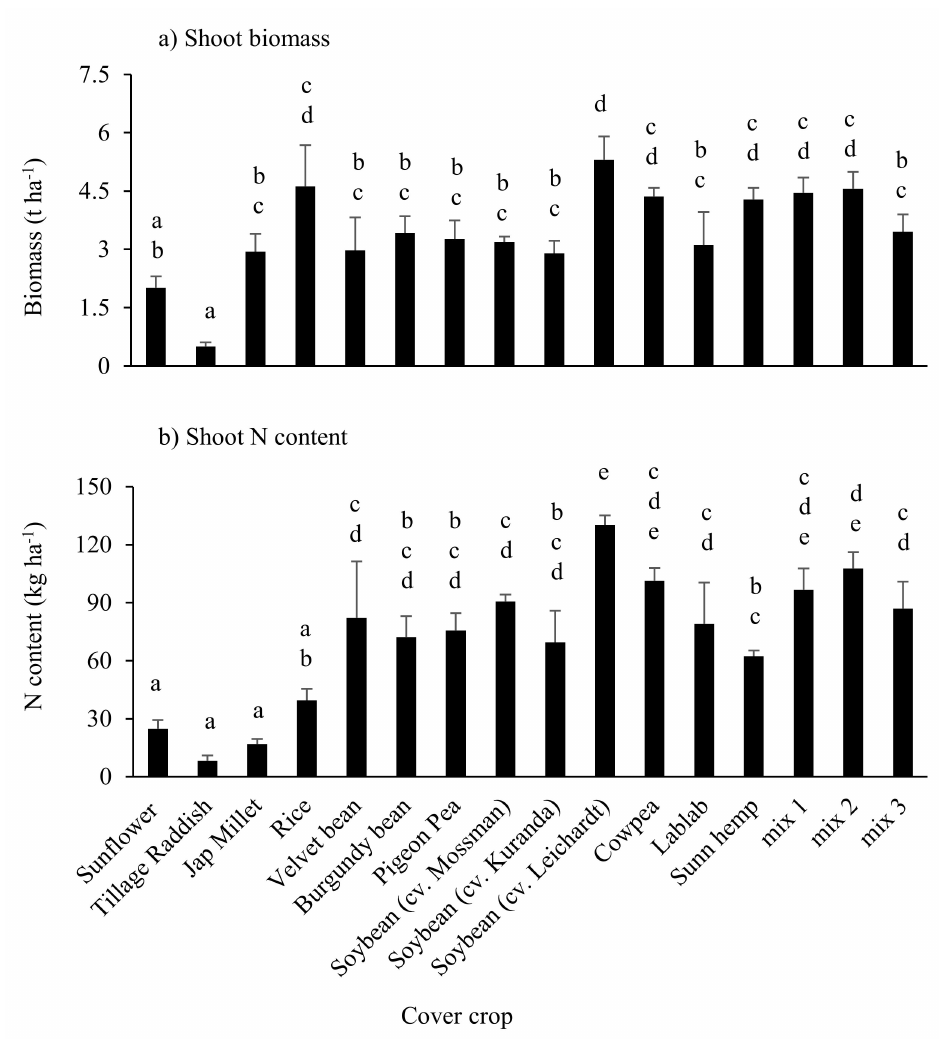
Figure 3. Shoot biomass production ( a ) and N content ( b ) in single-species and mixed-species cover crop treatments in trial 2. Error bars represent SEM ( n = 3). Means not followed by a common letter are significantly different at p ≤ 0.05. Note: cowpea plots contained a mixture of weeds and decayed cowpea residue as cowpeas died in February 2019 due to wet